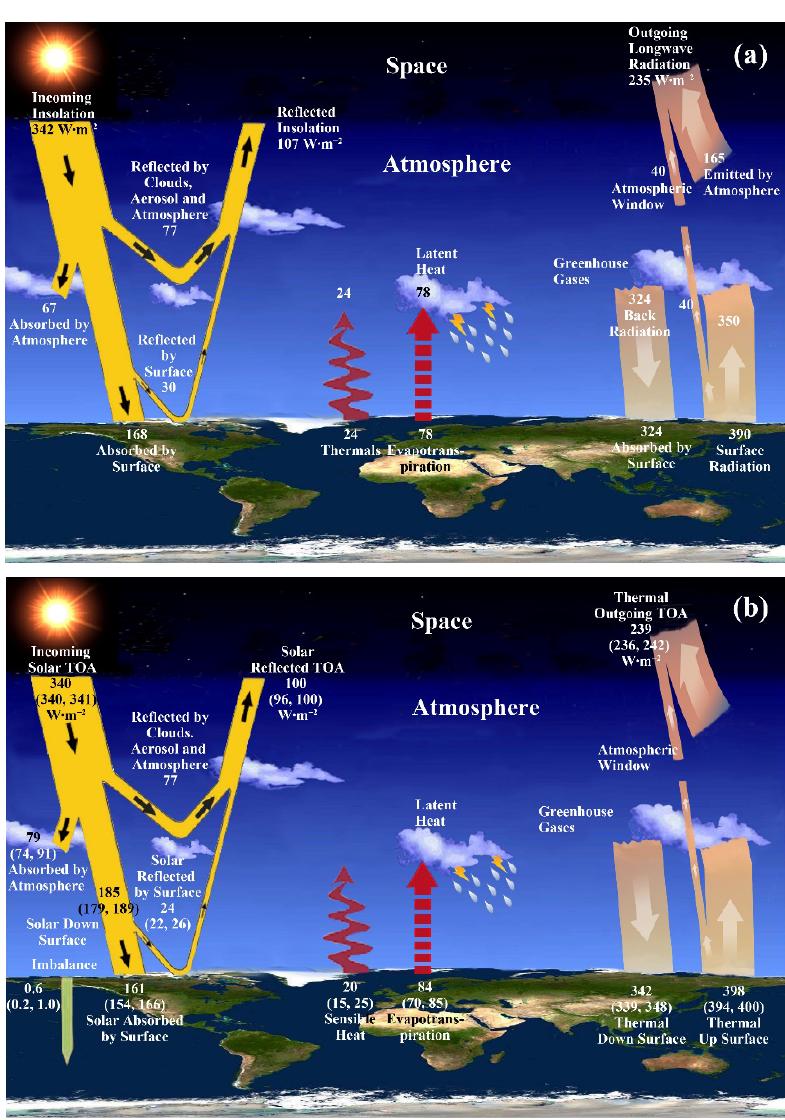
Figure 1. Schematic diagram of the global mean annual energy balance (W·m − 2 ) of the Earth. Numerical values are taken from ( a ) Kiehl el al. [3] and ( b ) Wild et al.